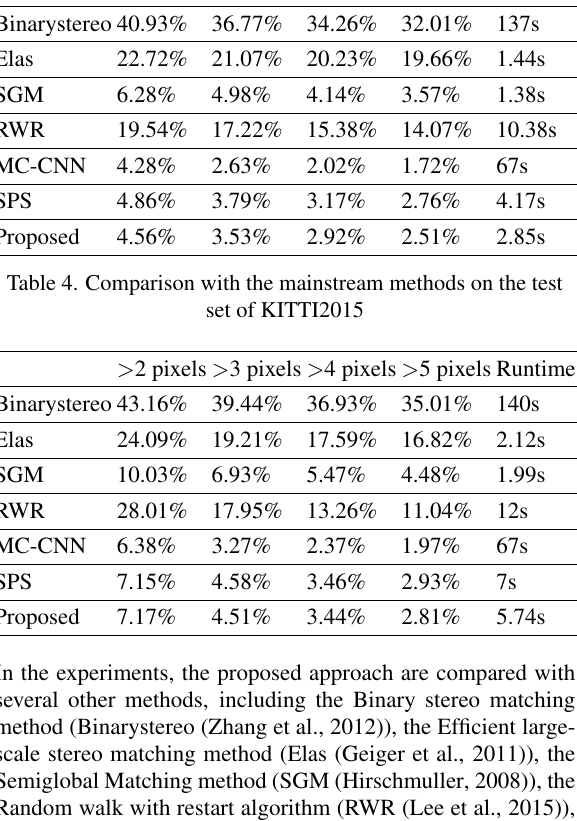
Table 3. Comparison with the mainstream methods on the test set of KITTI2012